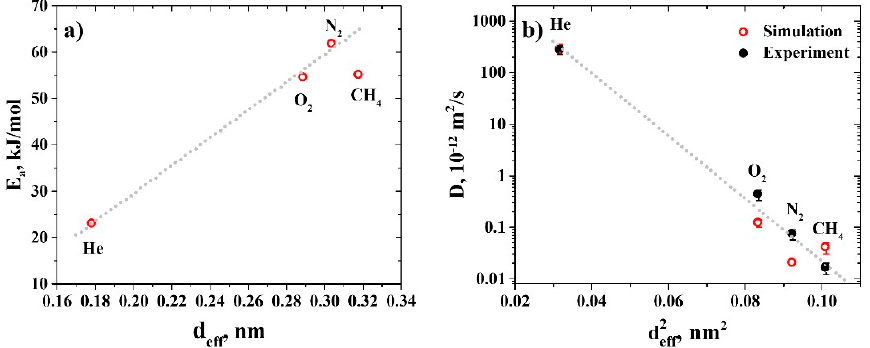
Figure 8. ( a ) Dependence of the activation energy of diffusion of the gases in R-BAPB on their effective diameter [51], obtained in molecular dynamics simulations. ( b ) The values of the diffusion coefficients of gases in R-BAPB at T = 300 K at their effective diameters [51], obtained in molecular dynamics simulations (blank red circles) and the experiment (solid black circles). Semi-logarithmic axes. The error bars denote the standard deviation (see main text for details). The gray lines are to guide the eye.